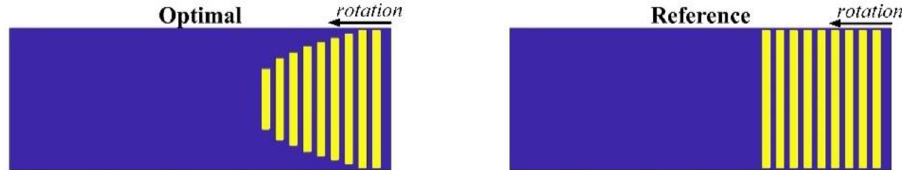
Fig. 7. The optimal and reference distributions of groove textures.